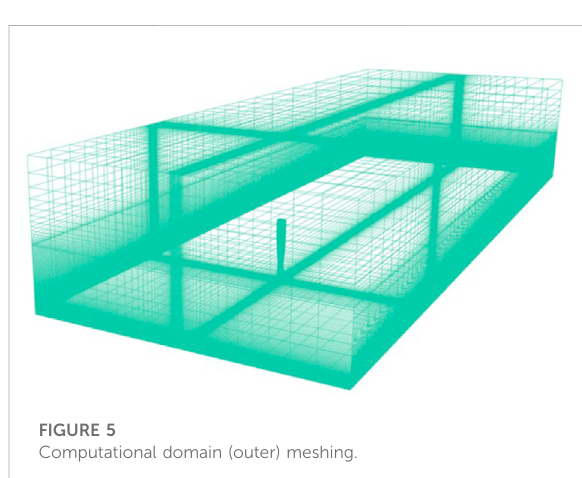
FIGURE 5 Computational domain (outer) meshing.